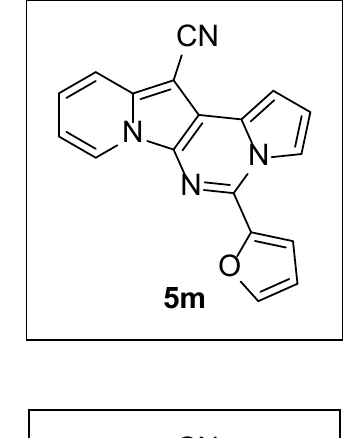
Yellow solid, m.p.: 238.1–238.6 ◦ C (29.5 mg, 90%); 1 H NMR (400 MHz, CDCl 3 )